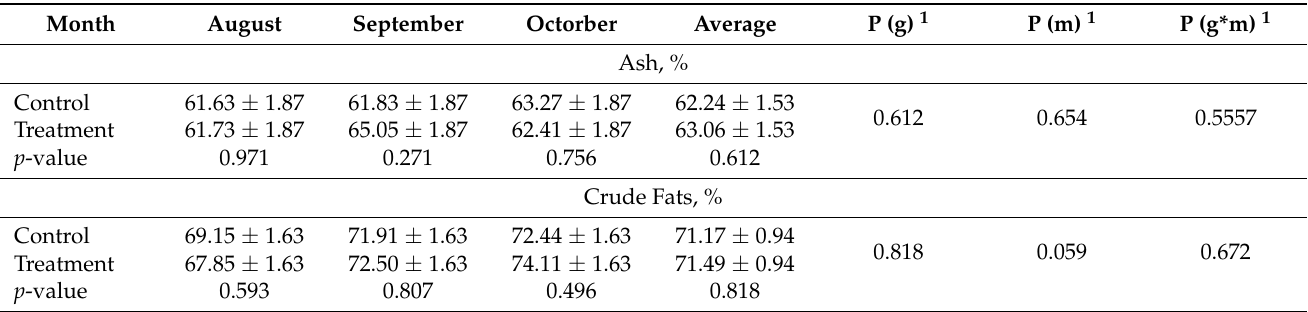
Table 9. Apparent total tract digestion of the diet in Control and Treatment